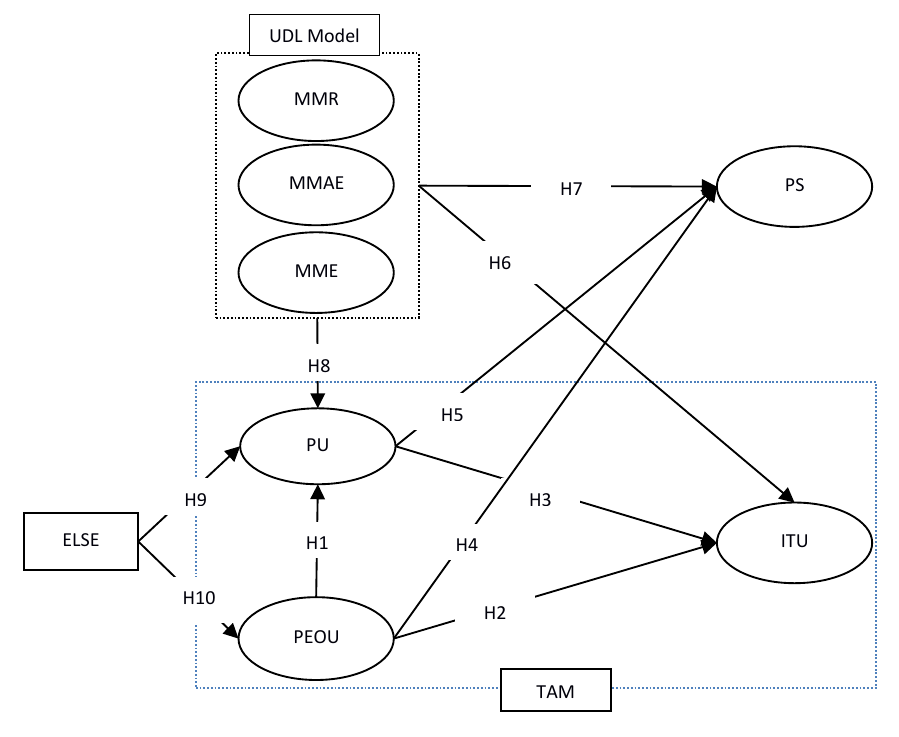
Figure 2. The research